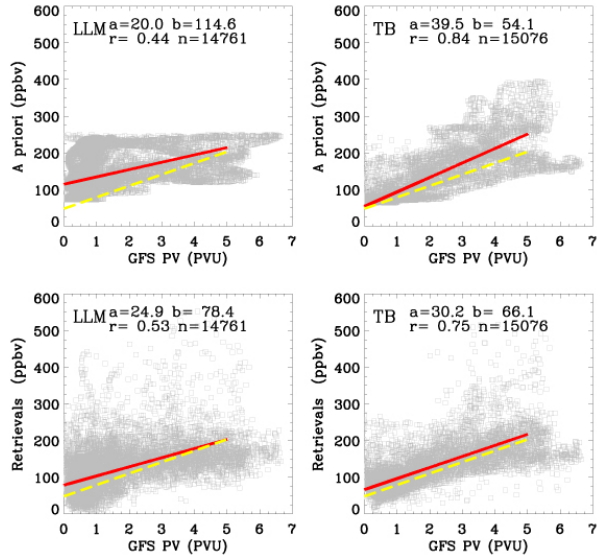
Fig. 7. The ozone–PV relationship at 300hPa in the spatial domain 40 ◦ W–60 ◦ E, 20–80 ◦ N. The scatter of GFS PV values vs. LLM and TB a priori values is plotted in the upper panels and the scatter vs. corresponding retrieval values in the lower panels. A linear fit of PV values from 0 to 5 PVU to data is shown in red. The legends show the slope ( a , ppbv/PVU) and intercept ( b , ppbv) of a linear regression, with correlation coefficient ( r ) and the number of data points ( n ). The linear regression of PV to in situ aircraft data from the START08 experiment, 31.08ppbv/PVU + 47.91ppbv, shown in Fig. 13 of Pittman et al. (2009), is shown with the dashed yellow